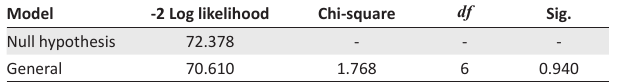
TABLE 5: Test for parallel lines.